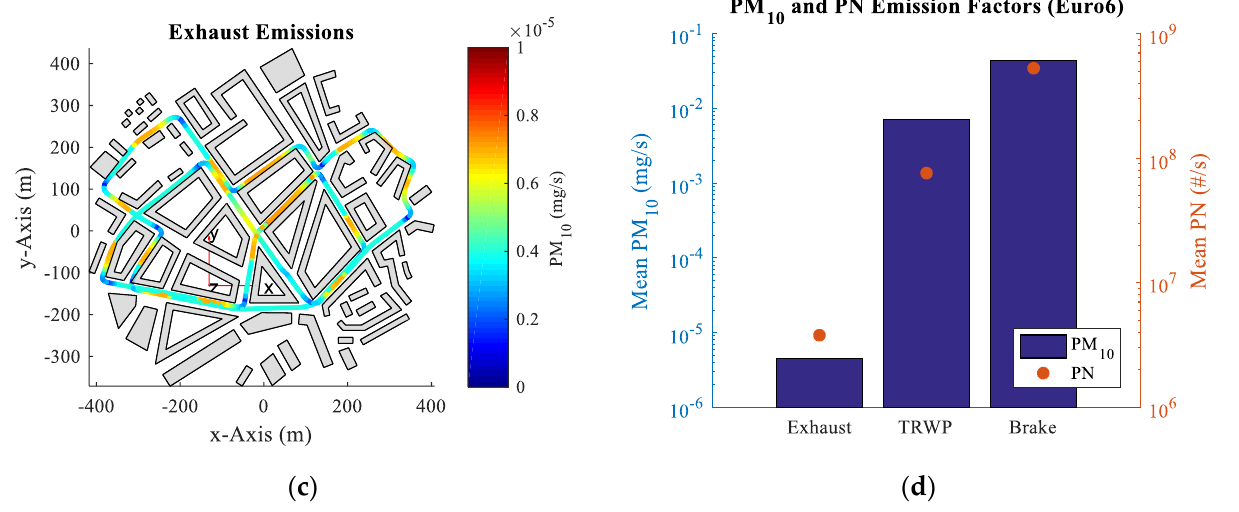
Figure 7. Estimated vehicle-related PM 10 contribution within a virtual city environment: ( a ) brake wear, ( b ) TRWP ( c ) exhaust emissions ( d ) virtual PM 10 and PN emission factors.